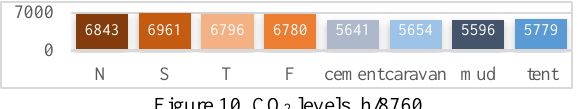
Figure 10. CO 2 levels, h/8760.